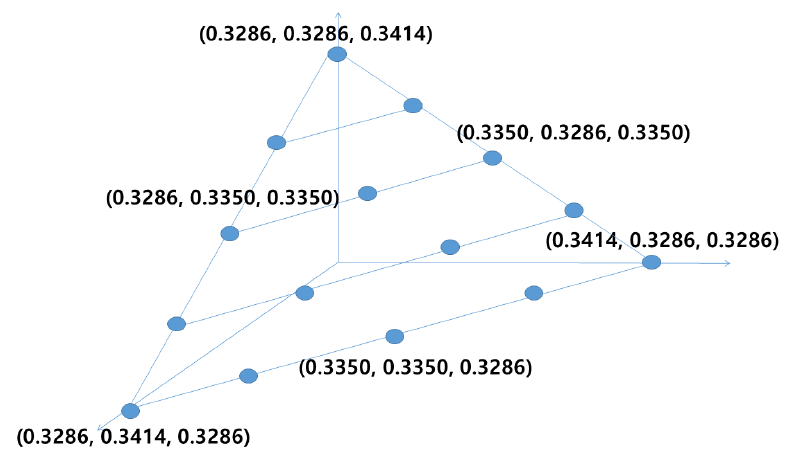
Figure 3. Normalized codebook of Pyramid Vector Quantization, L = 3, K = 4.